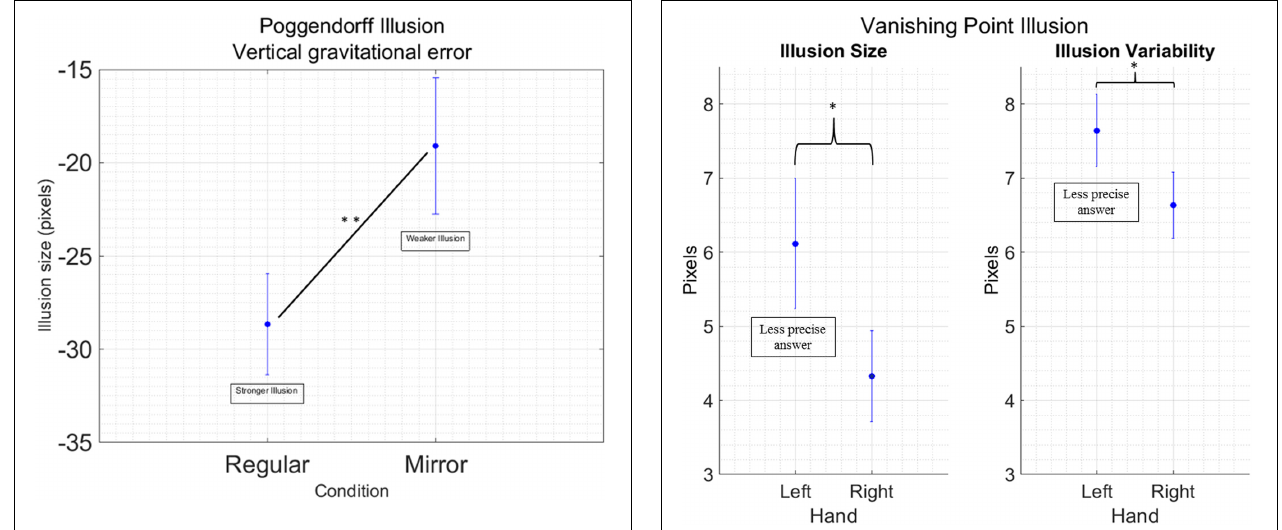
FIGURE 4 | Main effect of Hand in the Vanishing Point Illusion. Data are collapsed between the regular and mirror version, as Condition did not yield any significance in the main analysis. Vertical bars represent standard error of the mean. The y axis presents error size of the vertical gravitational error. Stars indicate a significant difference at p <